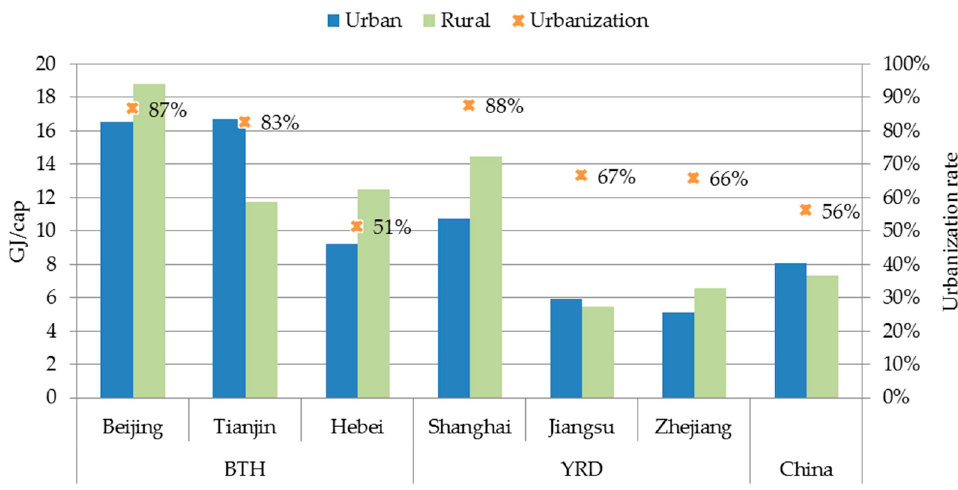
Figure 3. Energy intensity in residential sector and urbanization rate of study regions and China in 2015 (Data source: China Energy Statistical Yearbook 2016 and China Statistical Yearbook 2016 ).